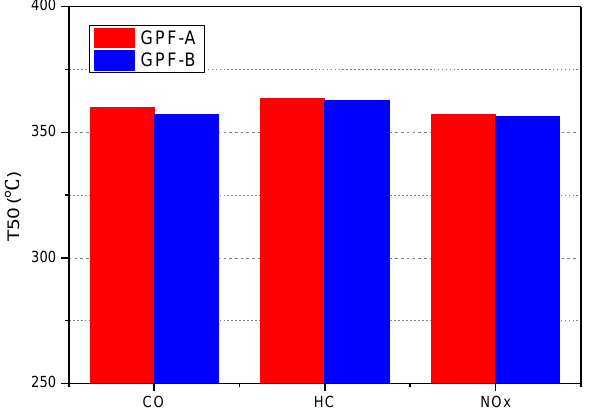
Figure 6. Influence of coating material bulk density on T50 of CO / HC / NOx.